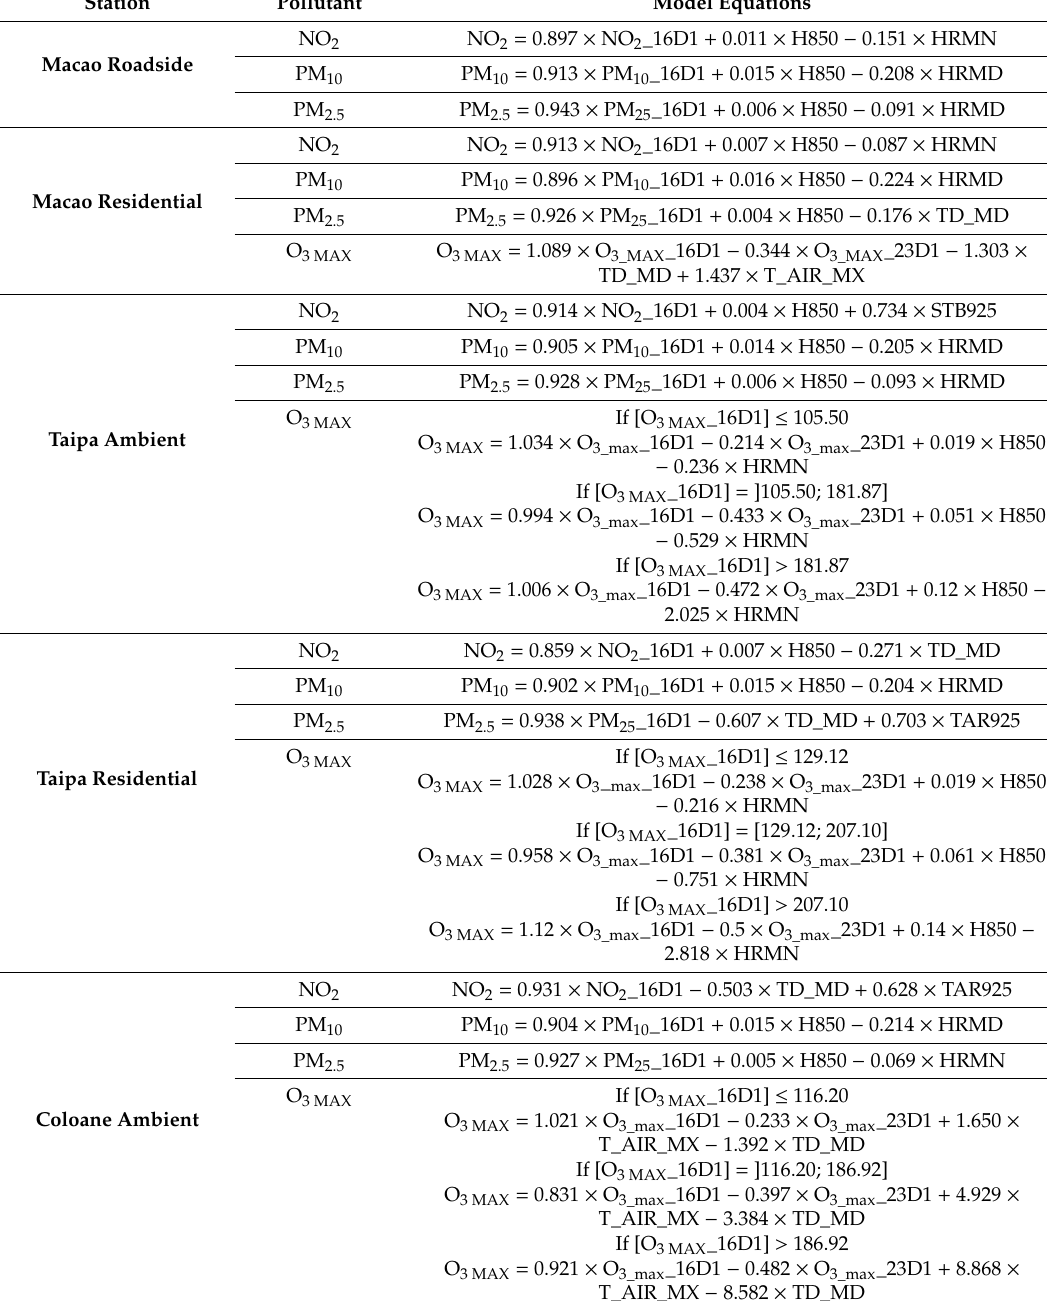
Table 4. Variables and model equations for each pollutant per air quality monitoring station in the 2013 to 2018